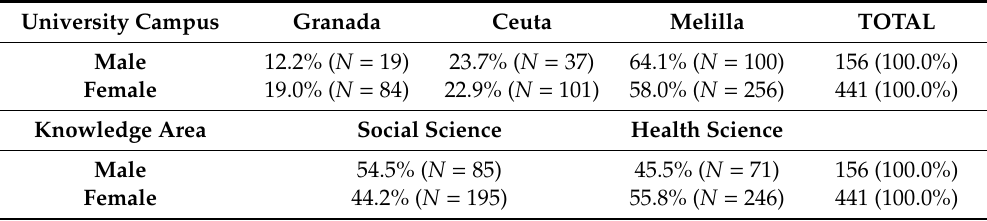
Table 1. Sample distribution and demographic